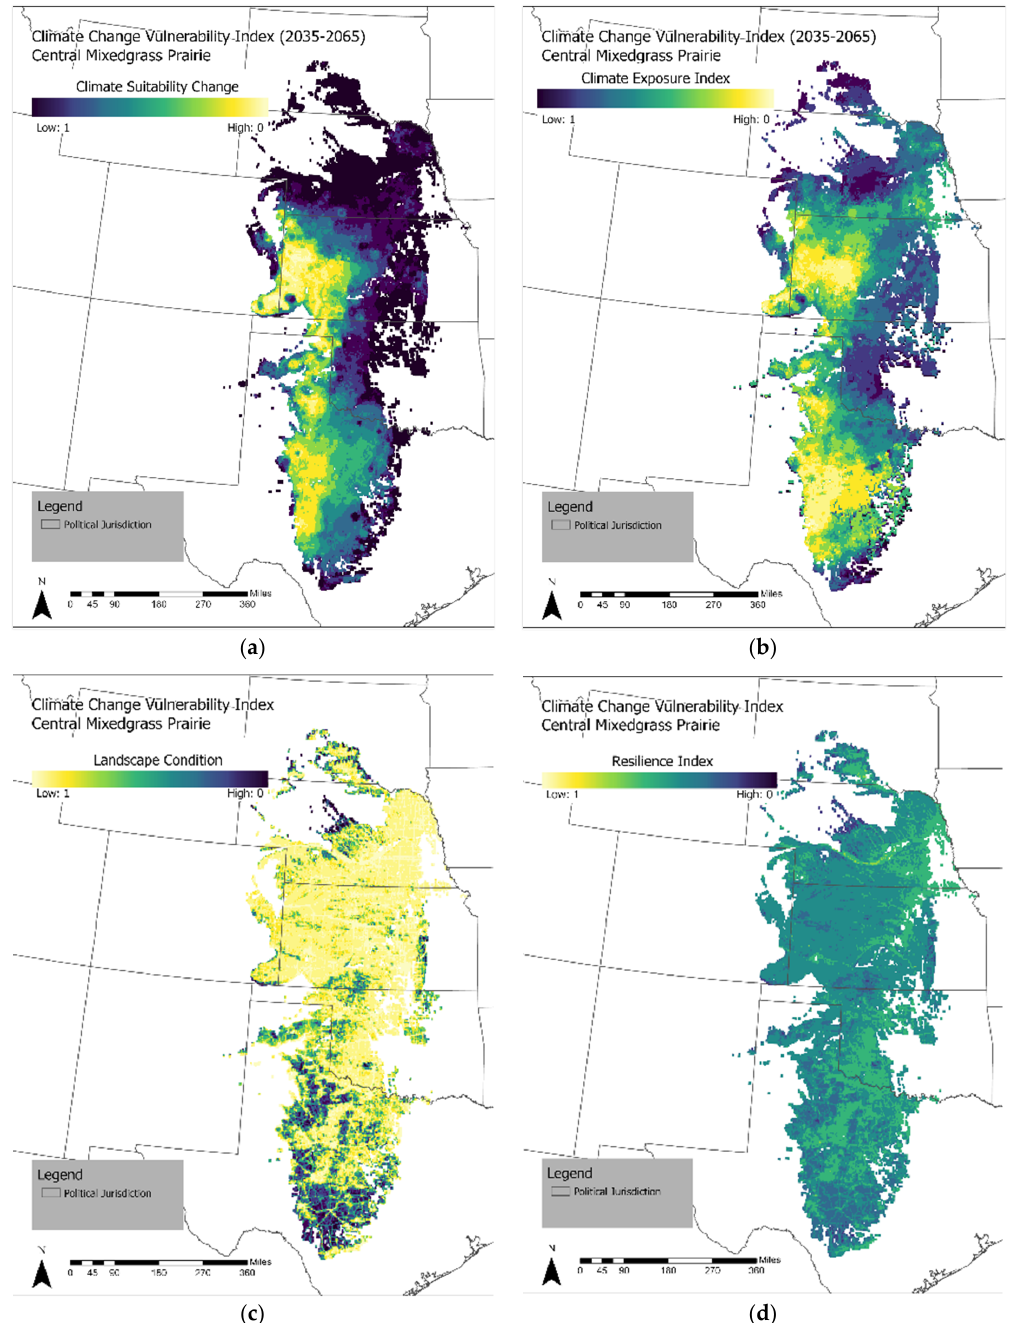
Figure 3. ( a – d ) Selected component measures of climate change vulnerability for 2035–2065, including Change in Climate Suitability (a) and overall Climate Exposure (b), Landscape Condition (c) and overall Resilience (d), summarized by 4 × 4 km 2 pixels, here displayed for Central Mixedgrass Prairie located from South Dakota south to central Texas.